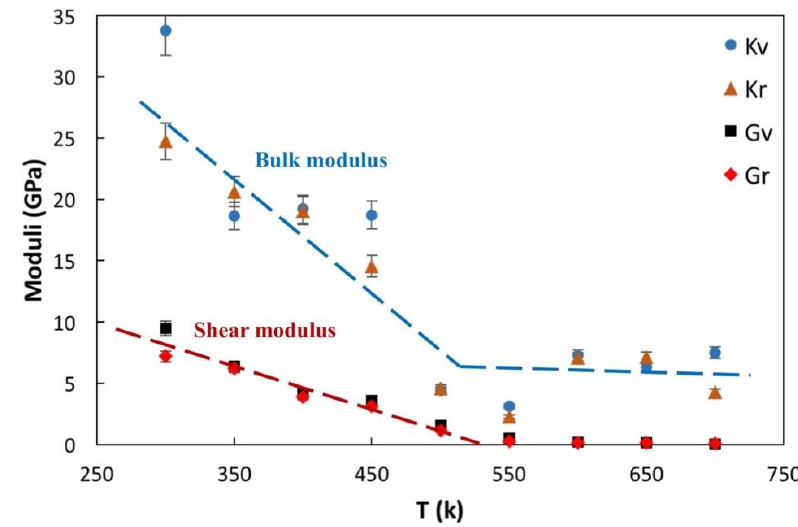
Figure 7. Bulk and shear moduli of Li 2 CO 3 obtained from the analysis of MD/MC simulations at different temperatures.